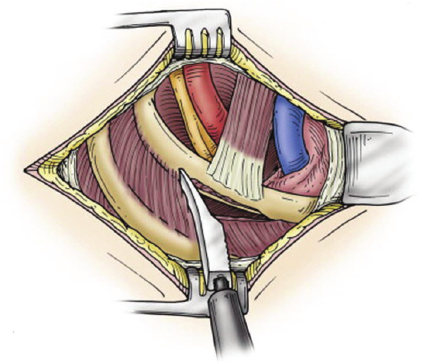
Figure 4: Use of the periosteal elevator to remove tissue from the first rib (reprinted with permission of Elsevier; see [8]).